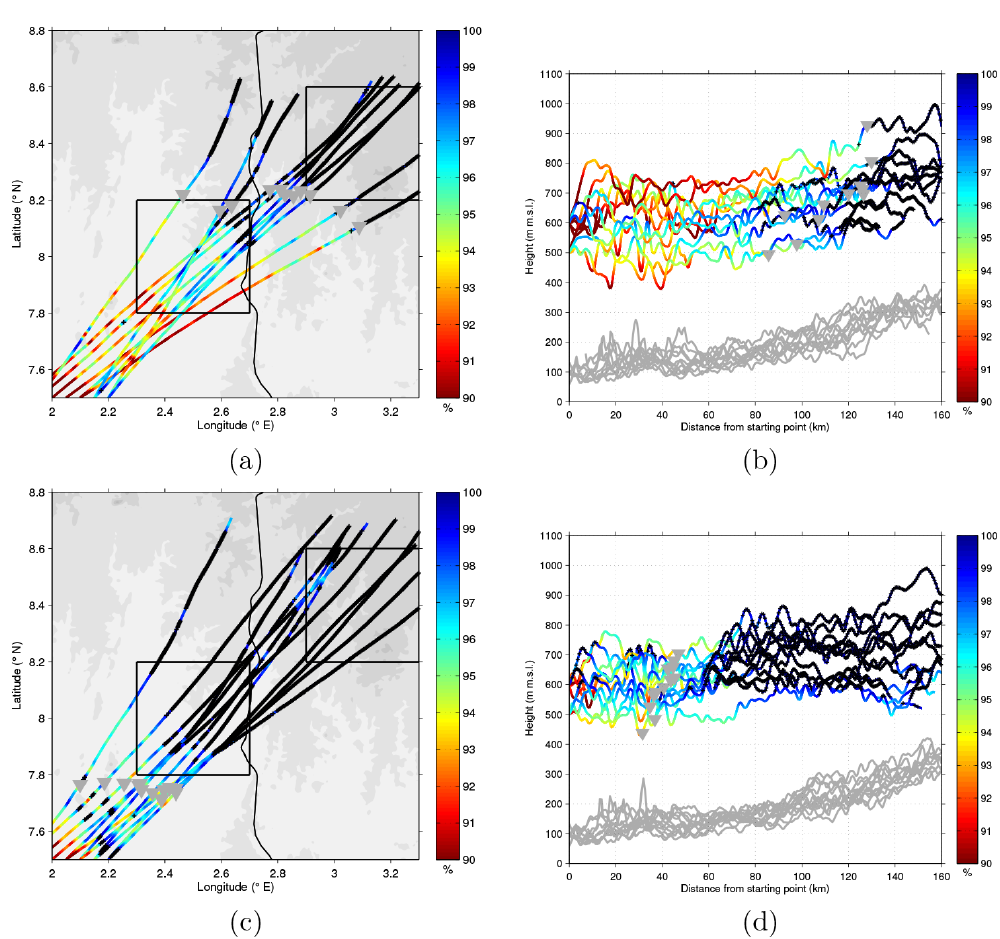
Figure 6. Relative humidity along trajectories of air parcels started at 7.5 ◦ N and between 1.9 and 2.2 ◦ E between 500 and 700mm.s.l. at 00:00UTC (a, b) and at 02:00UTC (c, d) . Black markers indicate non-zero liquid water content and grey triangles indicate the beginning of phase 2 for the respective air parcels. In (a) and (c) , the boxes mark SAVE and HILLS, respectively, and terrain height is shown as grey shading with darker colour indicating higher terrain. In (b) and (d) , grey lines indicate terrain height along the